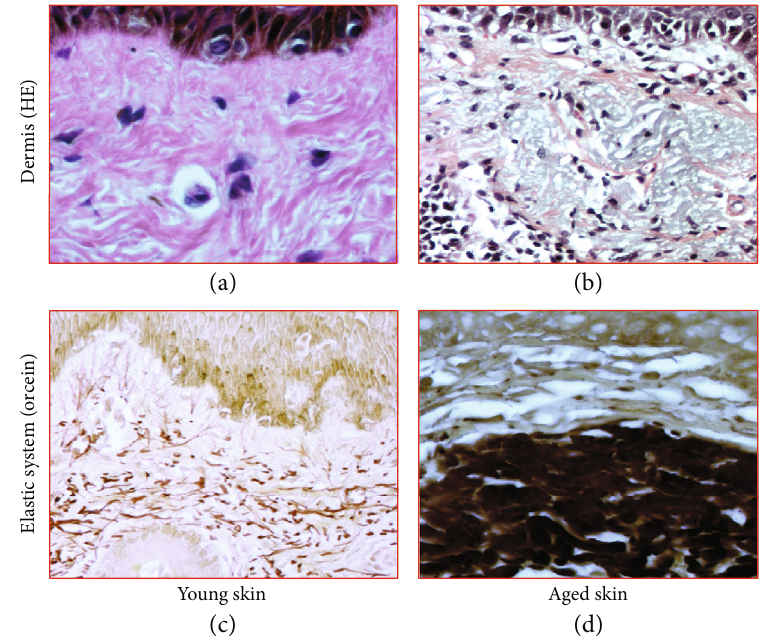
Figure 1: Histomorphological study of the skin. Skin biopsies: stained by (a, b) hematoxylin-eosin (HE) and (c, d) orcein: with previous oxidation with oxone to detect new elastic fi bers. In (a), histological sections representative of young skin showing an organized arrangement of the structural components of the dermis with few in fl ammatory cells. In (b), intense in fl ammatory in fi ltrate and presence of degenerated material in the dermis, characteristic of collagen basophilic degeneration. In (c), microphotography of the elastic system: oxytalan fi bers and elaunin fi bers perpendicular to the DEJ; mature elastic fi bers positioned horizontally in the deep dermis in a young skin. In (d), reduction of oxytalan fi bers in zone 1 and accumulation of reactive material for oxidized orcein in the papillary and reticular dermis (actinic elastosis, zone 2). Original magni fi cation: 4x (objective